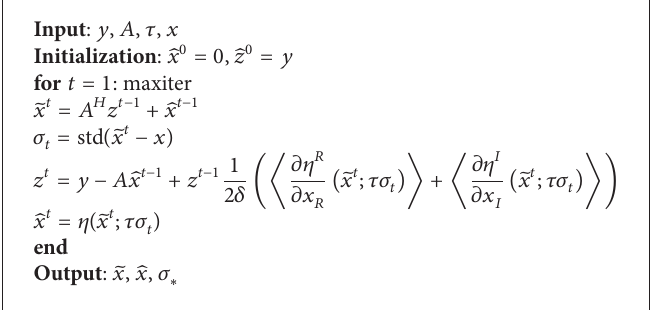
Algorithm 1: Ideal CAMP algorithm.